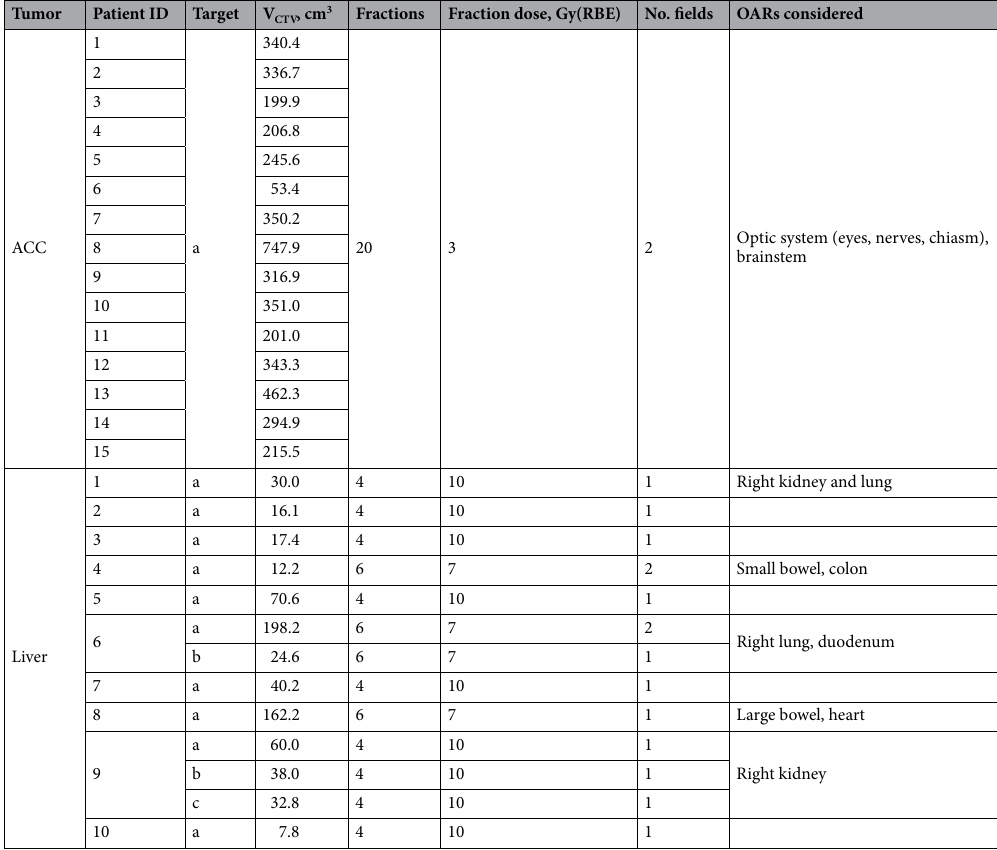
Table 1. Adenoid cystic carcinoma (ACC) and liver patient plans characteristics summarizing the numbers and sizes of clinical tumor volumes, fractionation schemes (number and dose per fraction), numbers of fields, and organs at risk considered during the plan